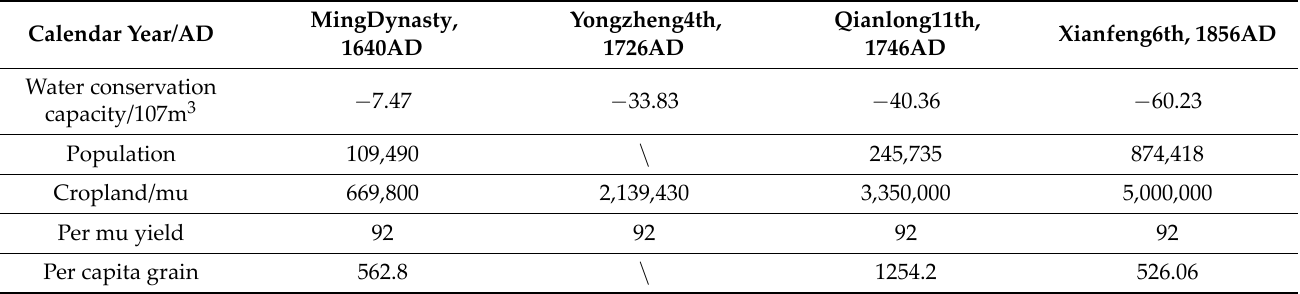
Table 5. The changes in the distribution ofwater conservation capacity inthe Hehuang valley during the Ming and Qing Dynasties.